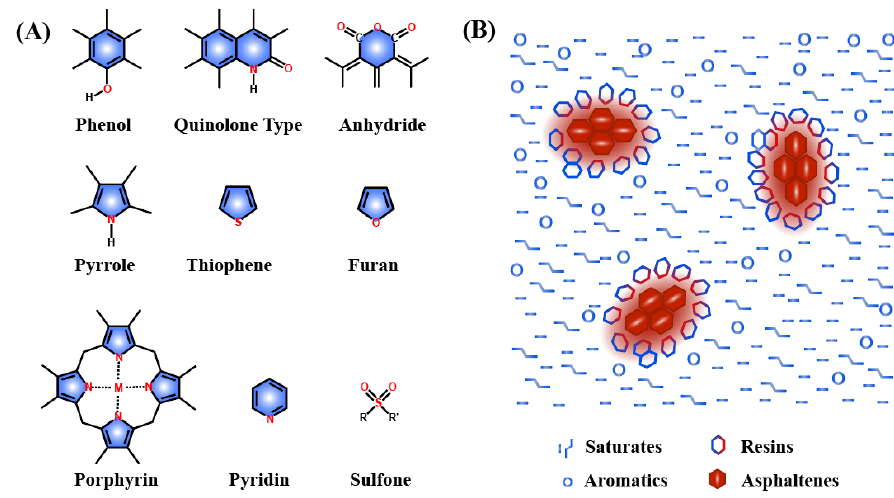
Figure 6. ( A ) Typical functional groups present in asphalt; ( B ) colloidal structure of asphalt [34]. Table 2. Chemical properties of asphalt and four fractions